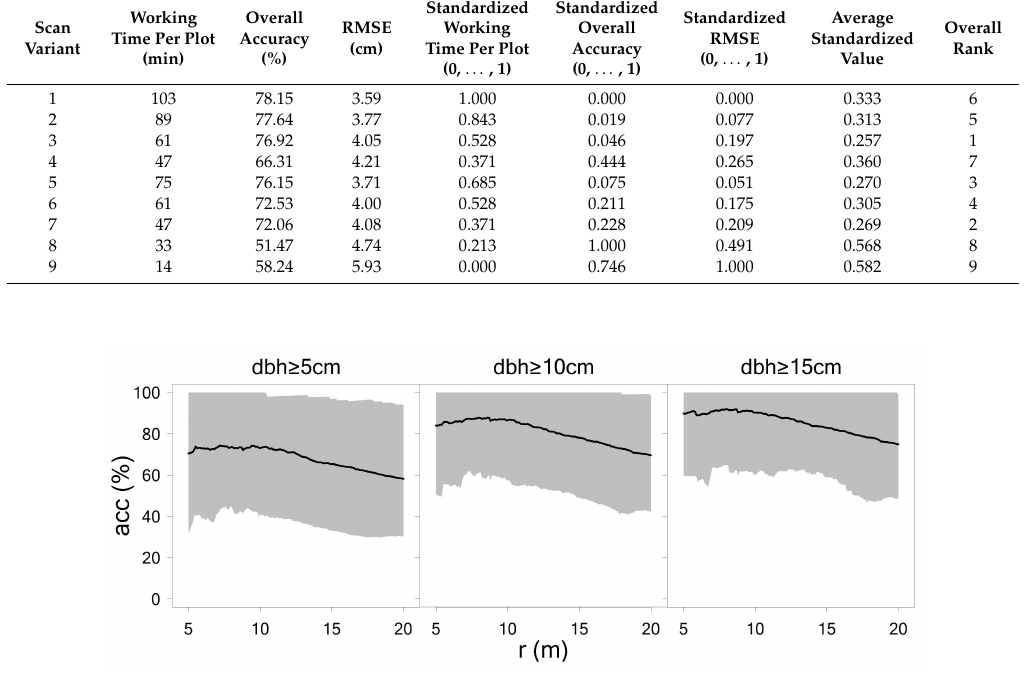
Figure 5. Overall accuracy achieved with scan variant 3 evaluated separately for lower dbh thresholds of 5, 10, and 15 cm and a fine grid of maximum radii. Solid black line indicates average overall accuracy of 23 sample plots. Gray shaded area indicates 95% interval for the 23